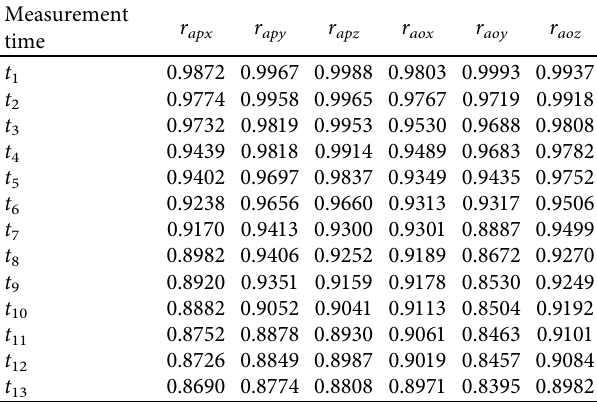
Table 4, the geometric accuracy retentivity declines with the longer running time of the machine tool because the geo- metric accuracies are degraded by wear. The accuracy re- tentivity of the geometric error vectors decreases with time, which means that the geometric errors of the machine tool are increasing and decreases particularly rapidly in the initial phase. However, the geometric accuracy retentivity of the error vectors is relatively stable at later time periods. The geometric accuracy retentivity of the measured geometric errors is greater than zero, and the identified values are under the allowance range.